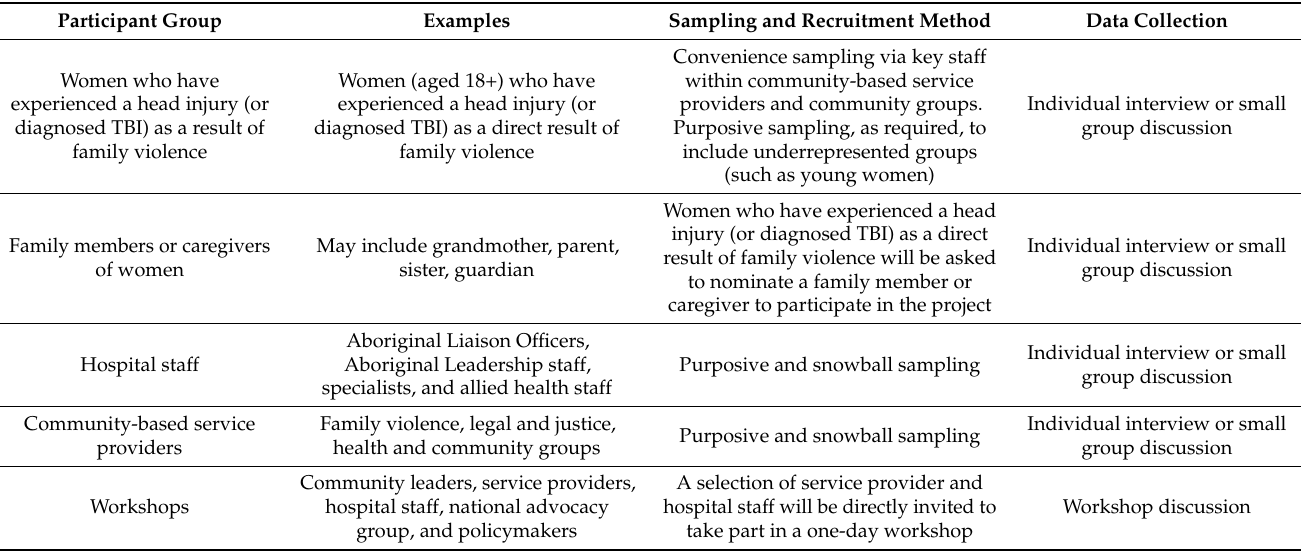
Table 1. Summary of participants, sampling, recruitment, and data